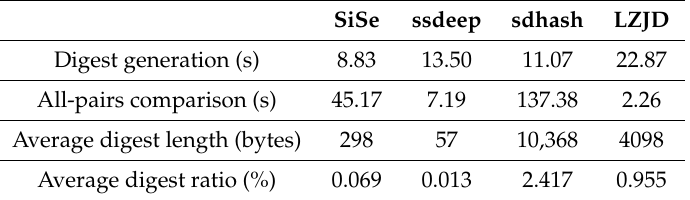
Table 28. Efficiency test